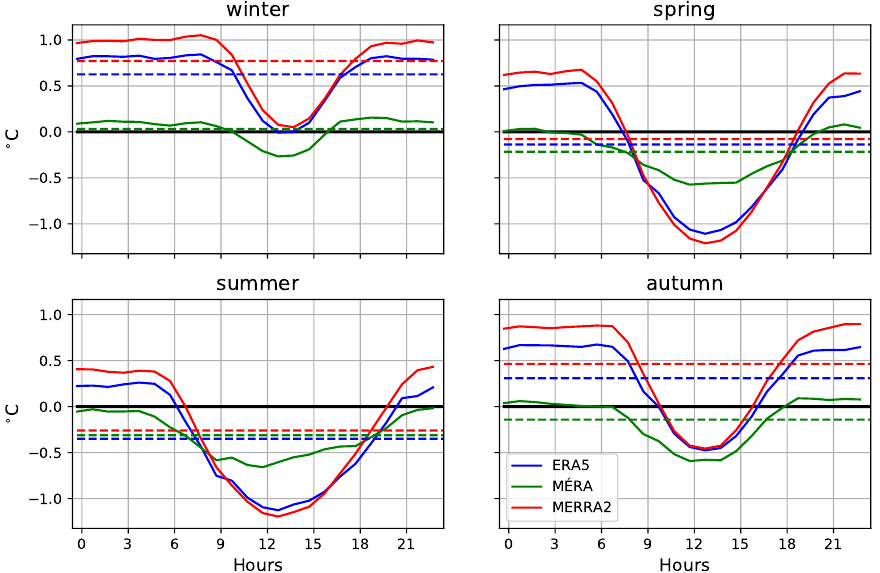
Figure 3. Diurnal mean error (ME) for 2 m temperature at the coastal station Belmullet in winter (DJF), spring (MAM), summer (JJA), and autumn (SON) for ERA5 ( blue ), MÉRA ( green ), and MERRA-2 ( red ). The horizontal dashed lines represent the overall average seasonal ME.